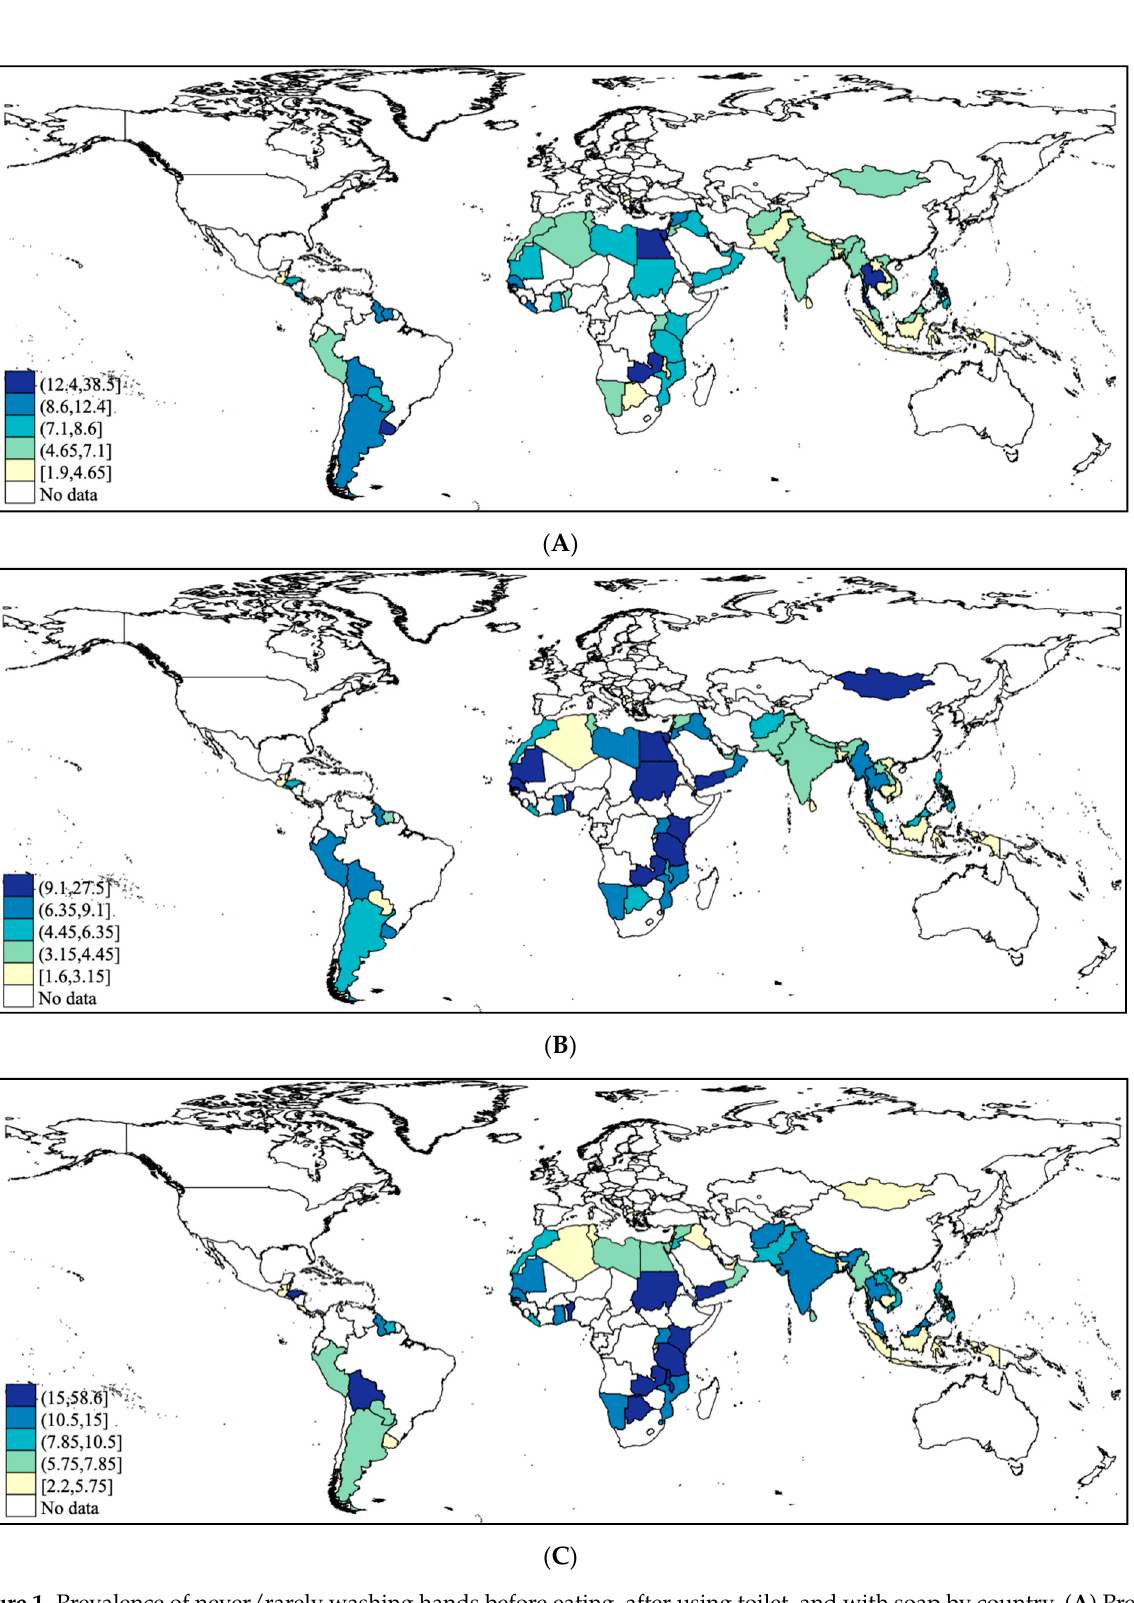
Figure 1. Prevalence of never/rarely washing hands before eating, after using toilet, and with soap by country. ( A ) Preva- lence of adolescents who never or rarely wash hands before eating; ( B ) Prevalence of adolescents who never or rarely wash hands after using the toilet; ( C ) Prevalence of adolescents who rarely or never use soap when washing hands.